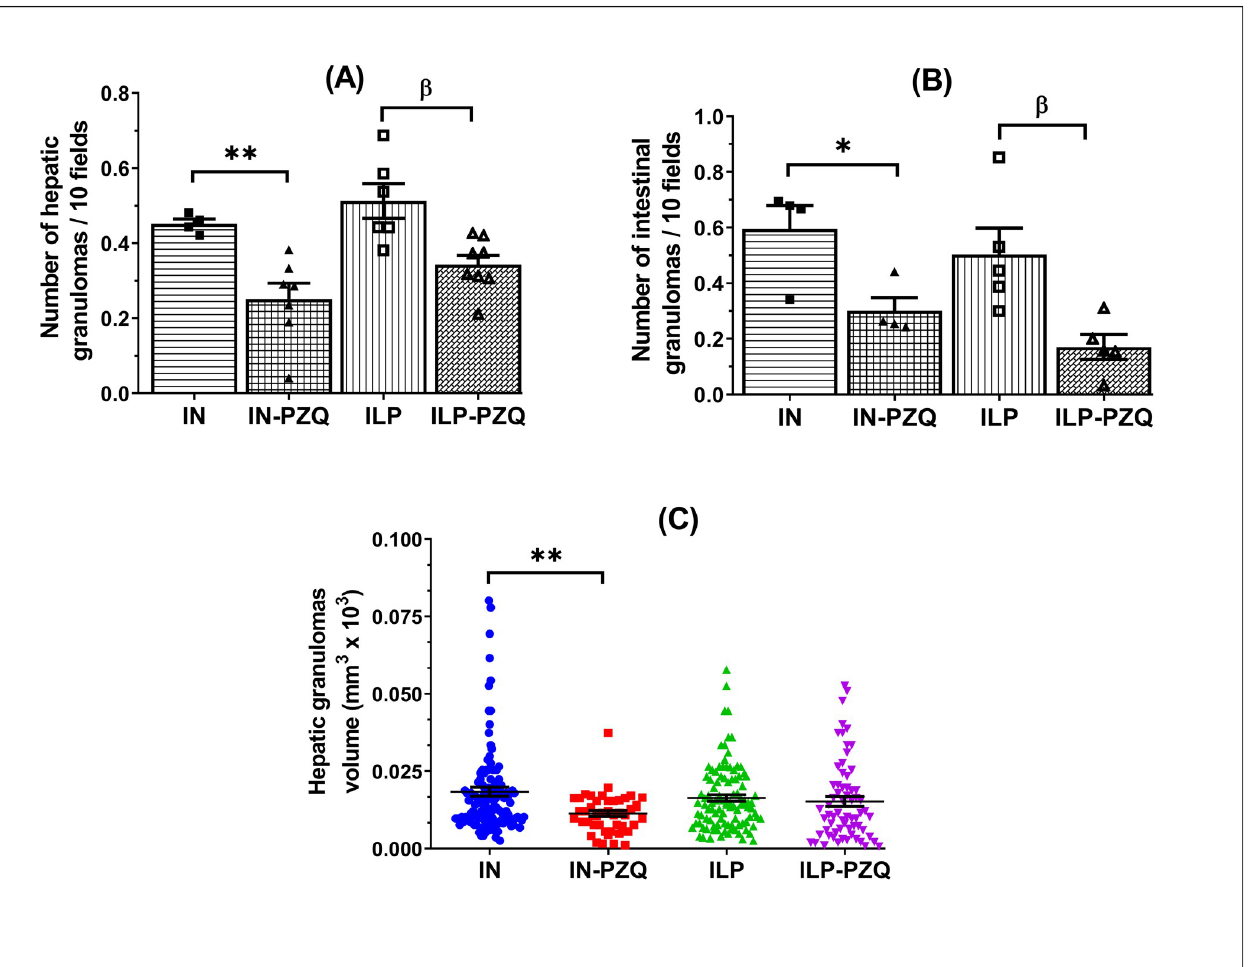
Fig 12. Effects of praziquantel treatment on the liver and intestine granulomas number and volume of Schistosoma mansoni -infected mice receiving a low-protein diet. Data are expressed as mean ± SEM (n = 4–8). Group IN: infected-untreated mice receiving a standard diet; group IN-PZQ: infected mice receiving a standard diet and treated with praziquantel; group ILP: infected-untreated mice receiving a low-protein diet; group ILP-PZQ: infected mice receiving a low-protein diet and treated with praziquantel. ANOVA followed by Turkey’s multiple comparison test. � P < 0.05; �� P < 0.01: values are significantly different from infected-untreated mice receiving the standard diet (group IN). β P < 0.05; values are significantly different from infected-untreated mice receiving the low-protein diet (group